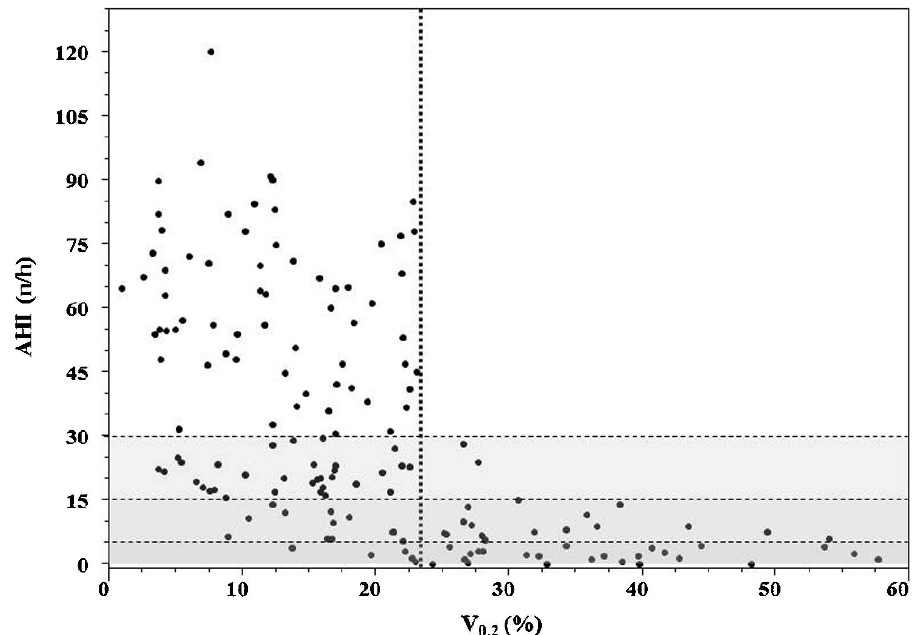
Figure 4 - The relationship between AHI and V 0.2 (%) with the optimal cutoff point (dashed vertical line) to discriminate subjects with AHI